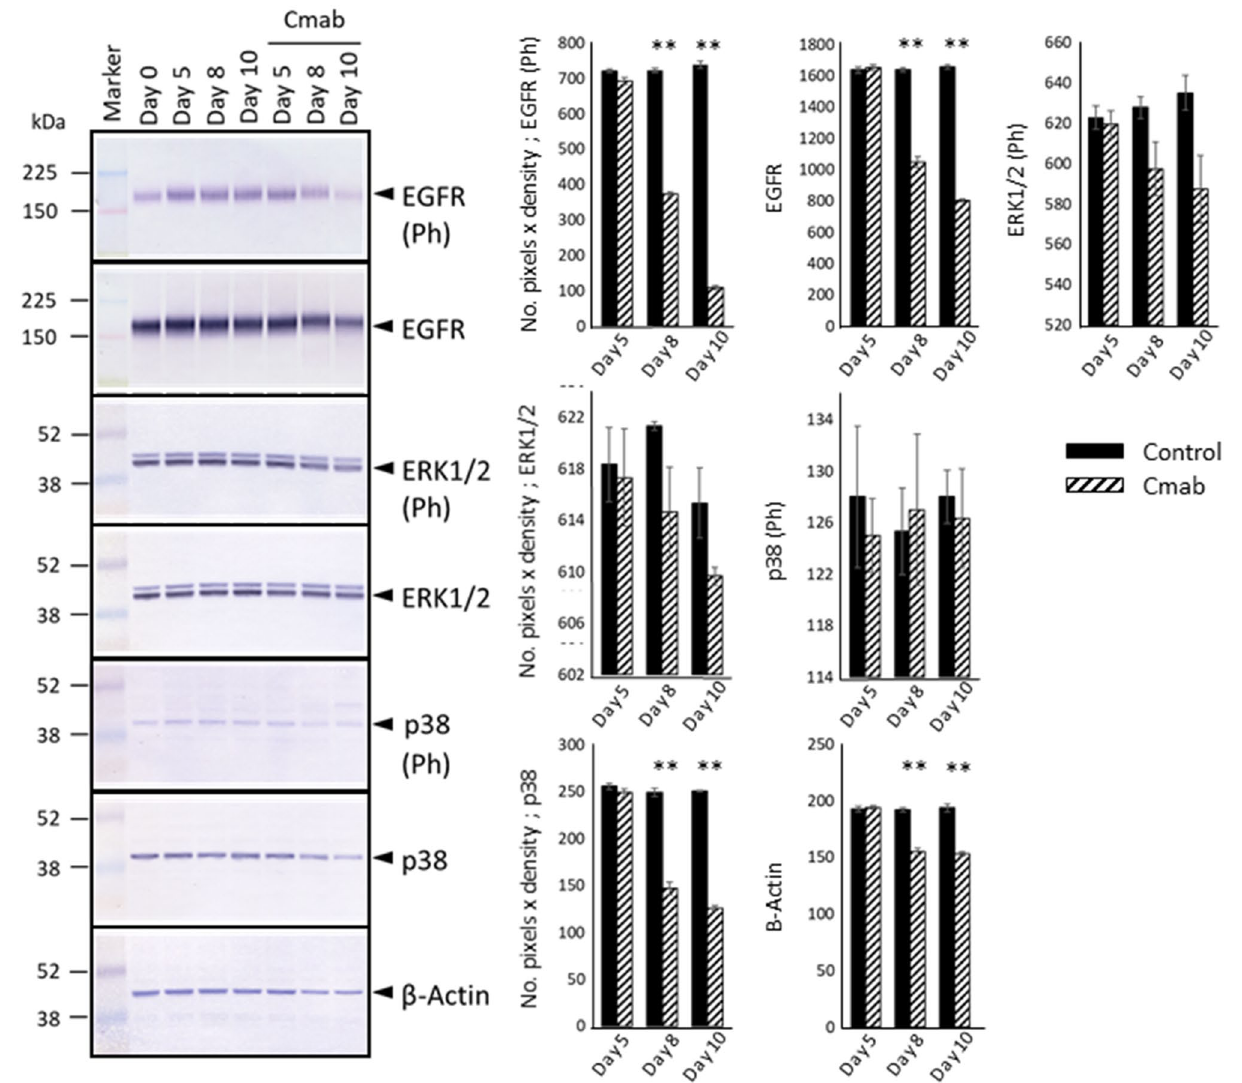
Figure 5. Western blotting (WB) analysis of control- and cetuximab-treated SAS cells. WB revealed the phosphorylation levels of ERK1/2, which are regulated by the EGFR pathway, decreased slightly after 8 days of cetuximab treatment. There was also no evidence of p38 activation, based on the levels of phosphorylated p38. Those expression levels were evaluated with the number of pixels × density and analyzed with t test (control- versus cetuximab-treated group). The experiment was repeated 3 times. * p < 0.05, ** p <